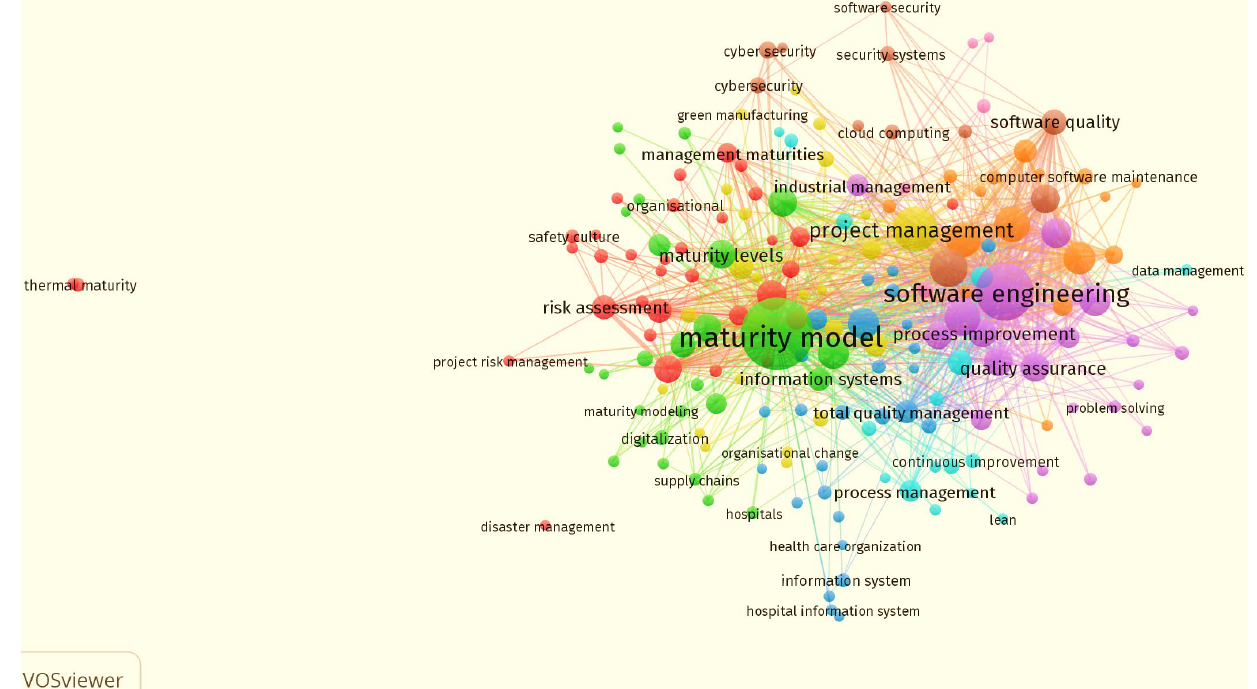
Figure 1. Areas of maturity model deployment .